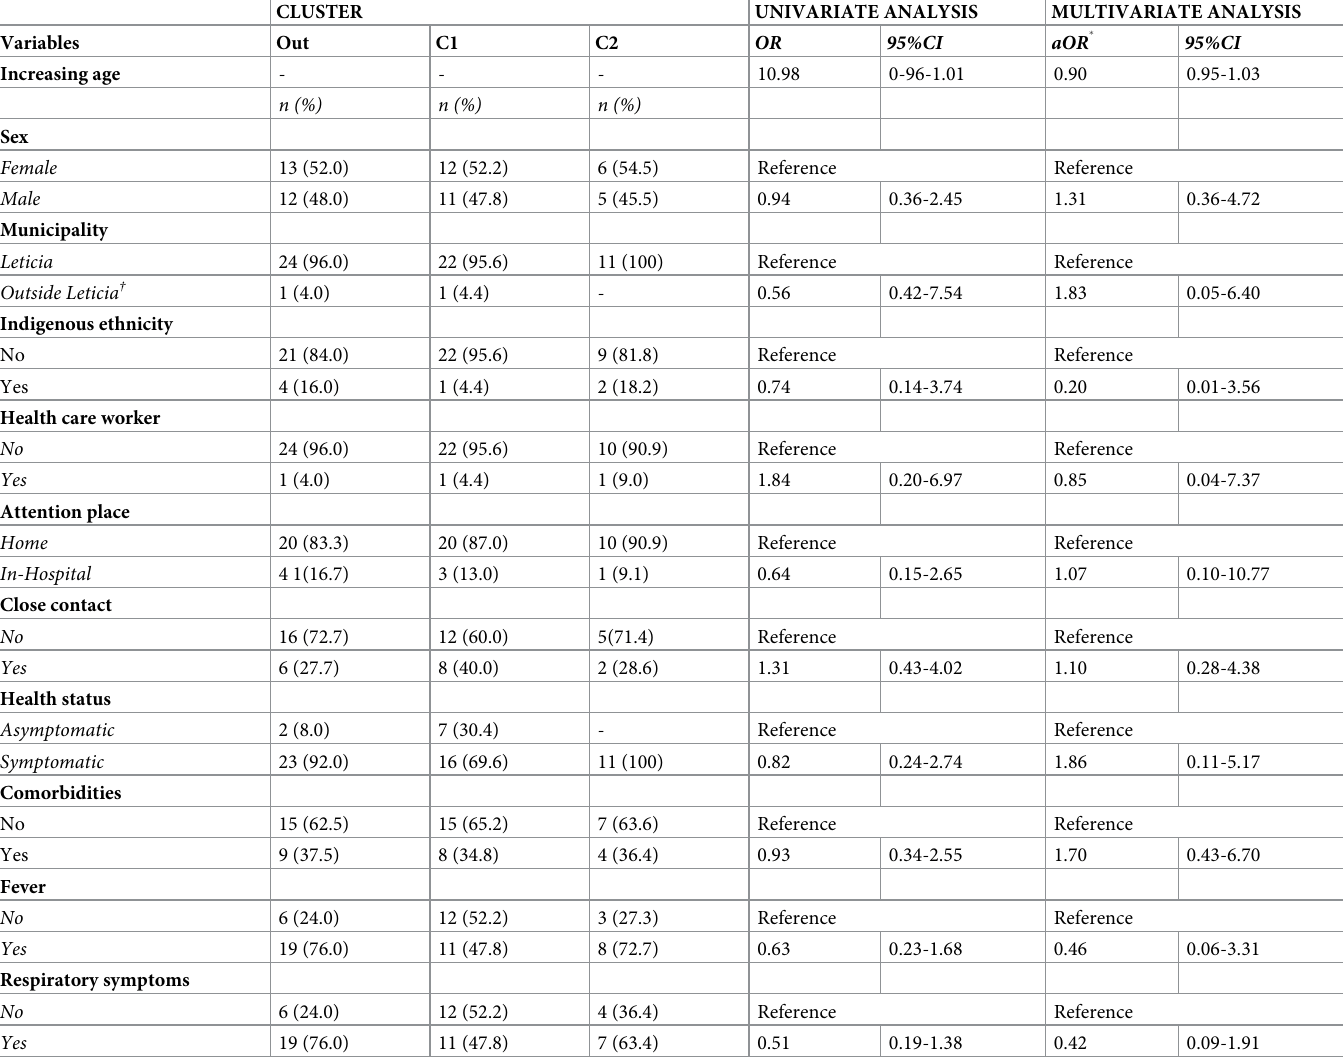
Table 2. Ordinal logistic regression model to assess the association between sociodemographic variables and transmission chain. C1 (N = 23); C2 (N = 11); Out, rep- resent the remaining Amazonas genomes (N = 25) evaluated in this